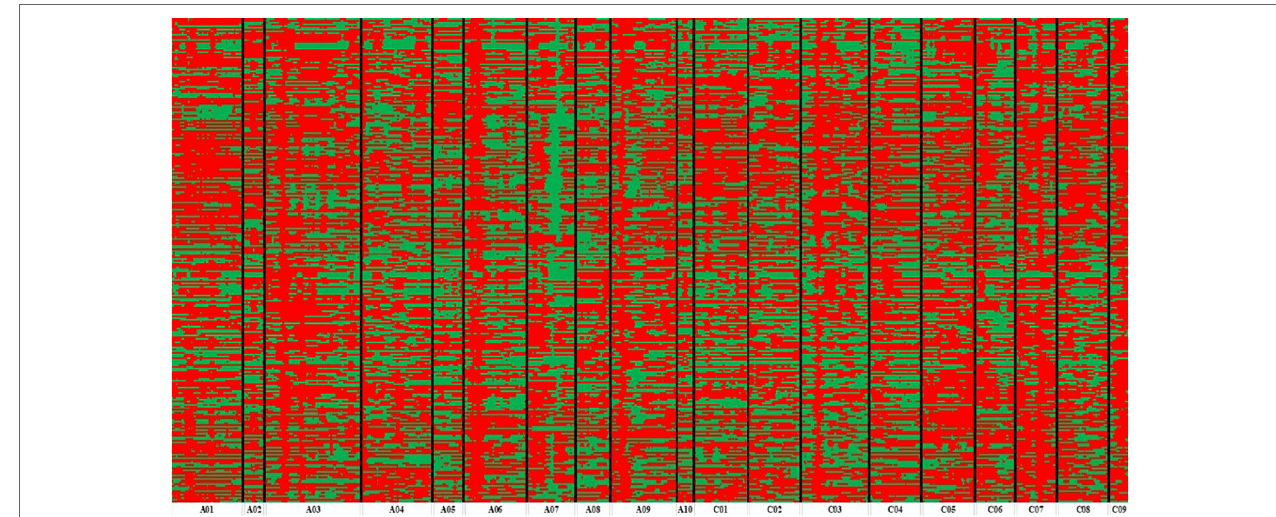
FIGURe 3 | Bin map of ZR population. Bin map consists of 14,658 bins inferred from re-sequencing-based high-quality single nucleotide polymorphisms (SNPs). Different colors represent different genotypes: red color exhibits ZS11 and green color as an indicator of R11.